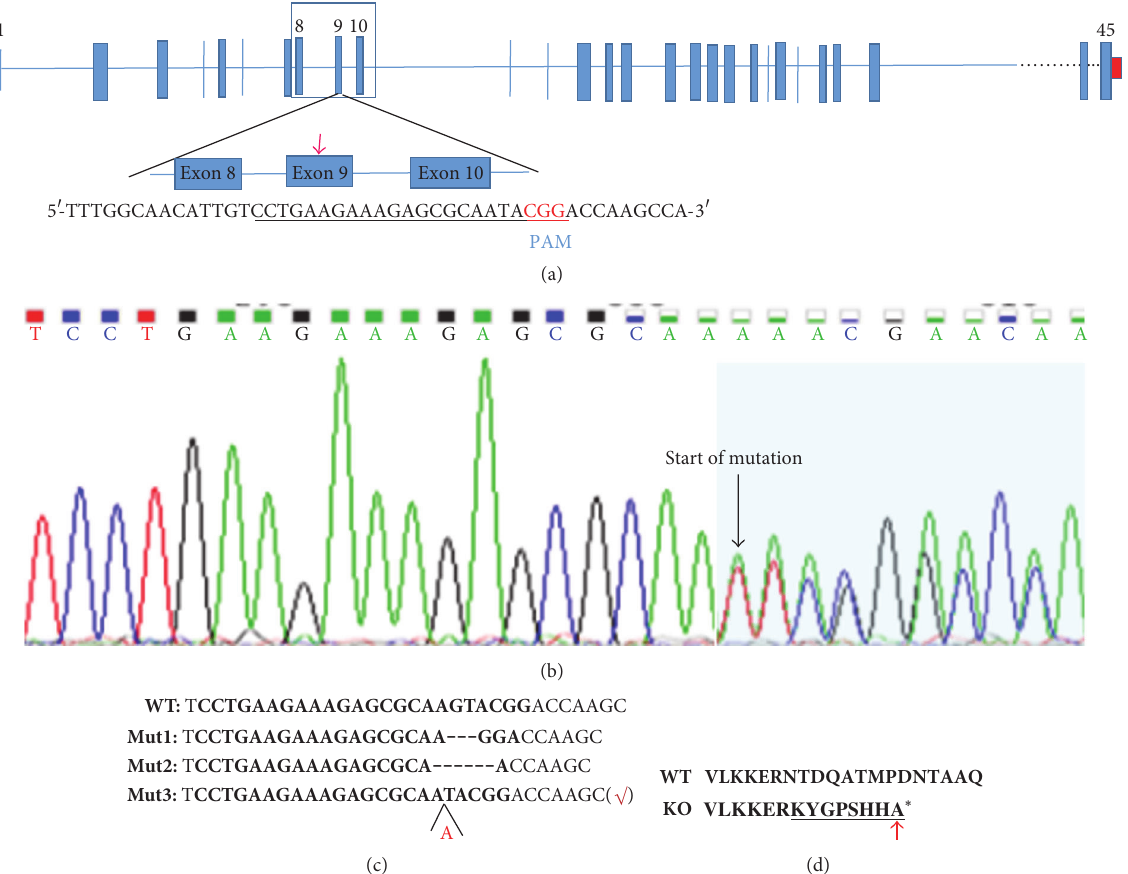
Figure 1: CRISPR/Cas9-mediated generation of Myh14 knockout mice. (a) Schematic diagram of sgRNA at Myh14 Exon 9 locus (indicated by the red arrow). The sgRNA sequence is underlined in black, and the PAM sequence is shown in red. (b) Sequencing chromatograms of Myh14 −/− mice. The sequence at the start of the mutated site becomes scrambled. (c) Three types of mutations (3, 6 bp deletions and 1bp insertion) were produced. Type 3 frameshift mutation was chosen for further analysis. (d) Frameshift mutation of Myh14 −/− mice. The mutation is underlined in black. “ ∗ ” indicates a premature stop codon. The translation of the protein is terminated at the point of the